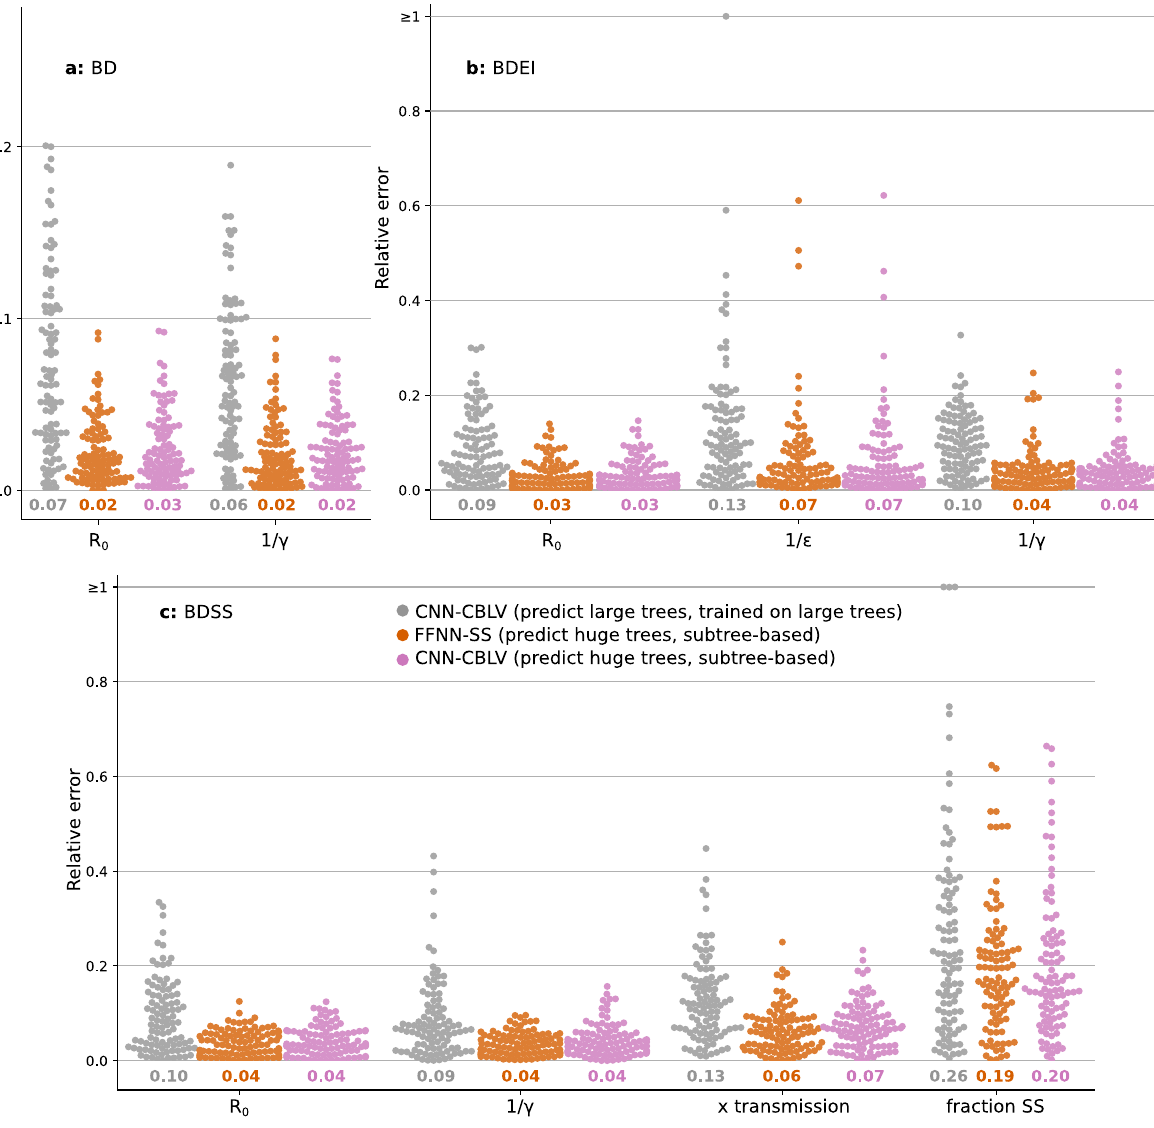
Fig. 4 Deep learning accuracy with ‘ huge ’ trees. Comparison of inference accuracy by neural networks trained on large trees in predicting large trees (CNN-CBLV, in grey, same as in Fig. 3) and huge trees (FFNN-SS, in orange, and CBLV-NN, in pink) on 100 large and 100 huge test trees. The training and testing large trees are the same as in Fig. 3 (between 200 and 500 tips each). The huge testing trees were generated for the same parameters as the large training and testing trees, but their size varied between 5000 and 10,000 tips. We show the relative error for each test tree. The error is measured as the normalized distance between the point estimates by neural networks and the target values for each parameter. We compare the relative errors for a BD- simulated, b BDEI-simulated and c BDSS-simulated trees. Average relative error is displayed for each parameter and method in corresponding colour below each